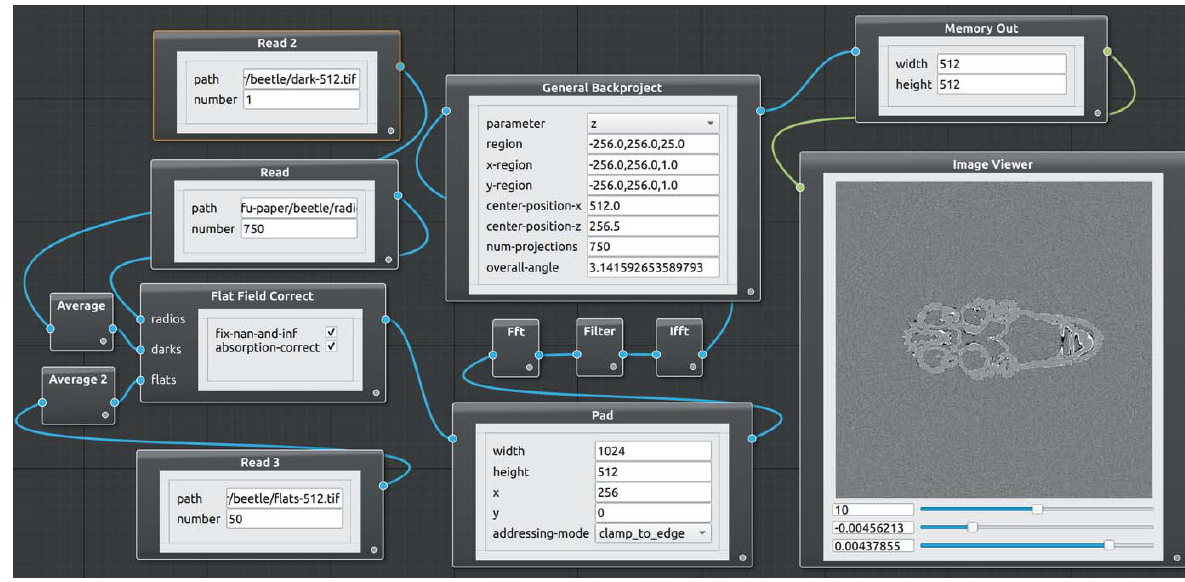
Figure 2 Main window of tofu flow showing tomographic reconstruction. Dark and flat field images are averaged and used to flat-field-correct the radiographs. The normalized images are padded in order to remove convolution outlier artifacts, Ram-Lak-filtered in the Fourier space, back projected and displayed.